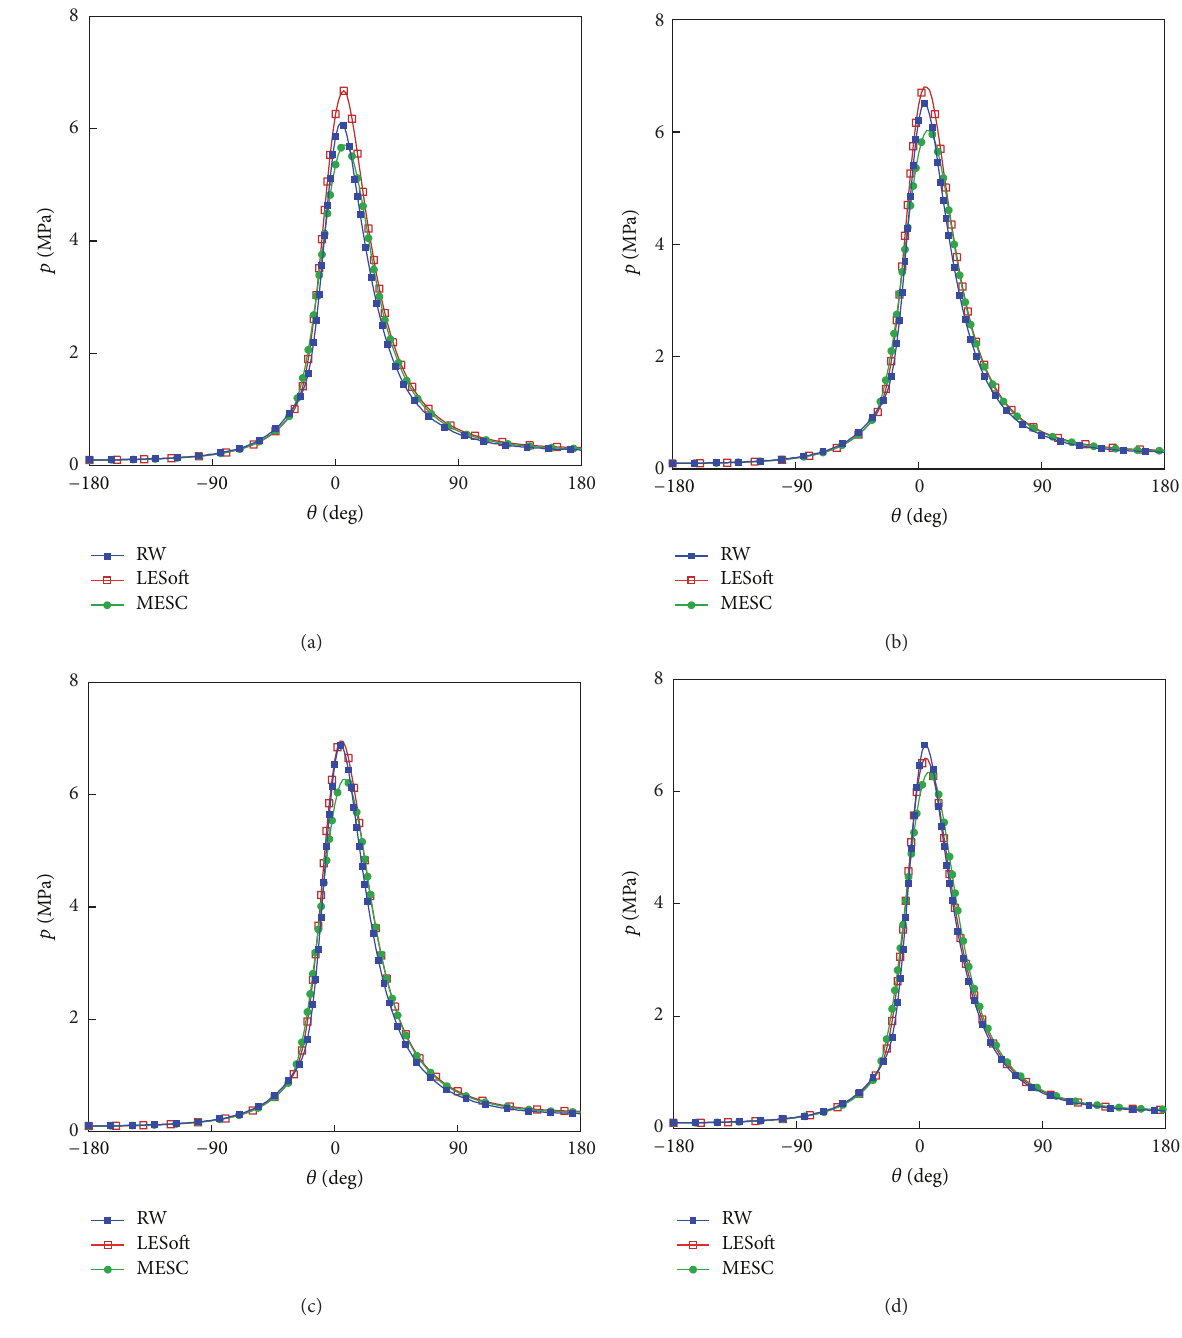
Figure 13: Profiles of pressure for air to fuel ratio of 0.8 (a), 0.9 (b), 1.0 (c), and 1.1